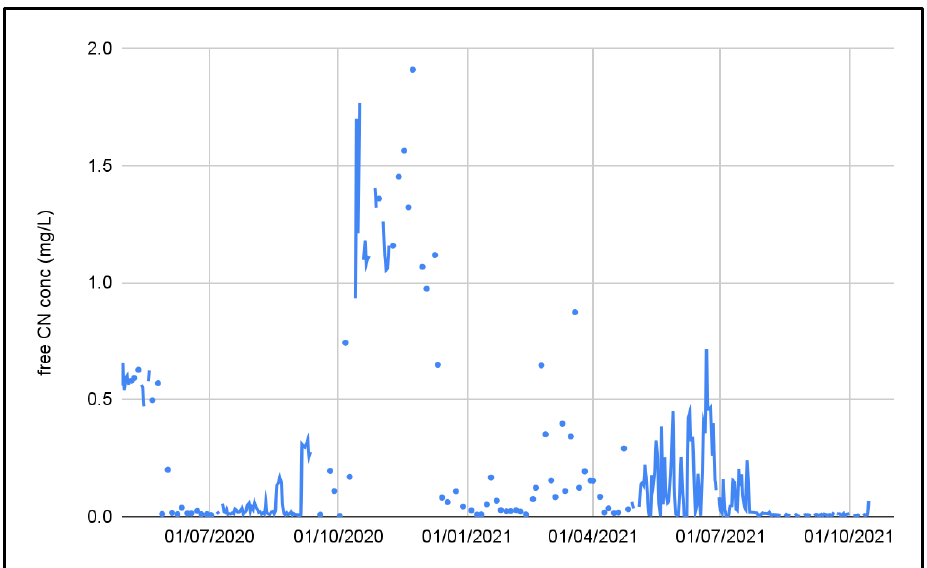
Figure 5. Free cyanide concentration in the pre-treated effluent.